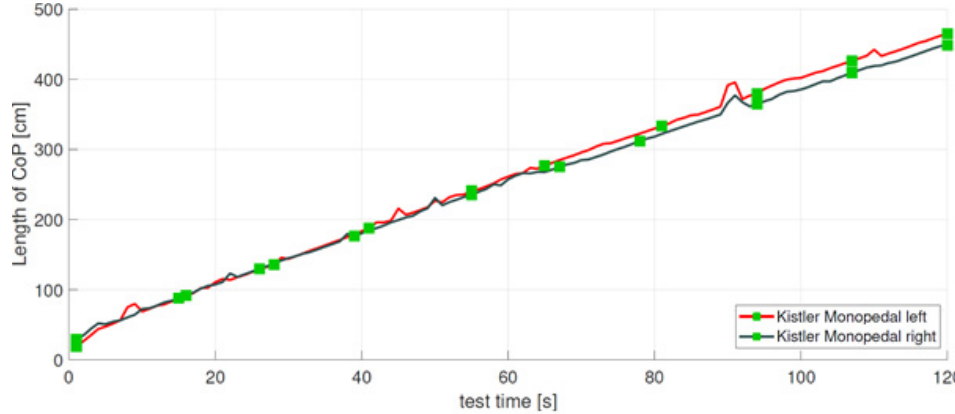
Figure 5. Absolute CoP length curve for monopedal stand over the measurement time, with left (red) and right leg (black). and right leg (black).